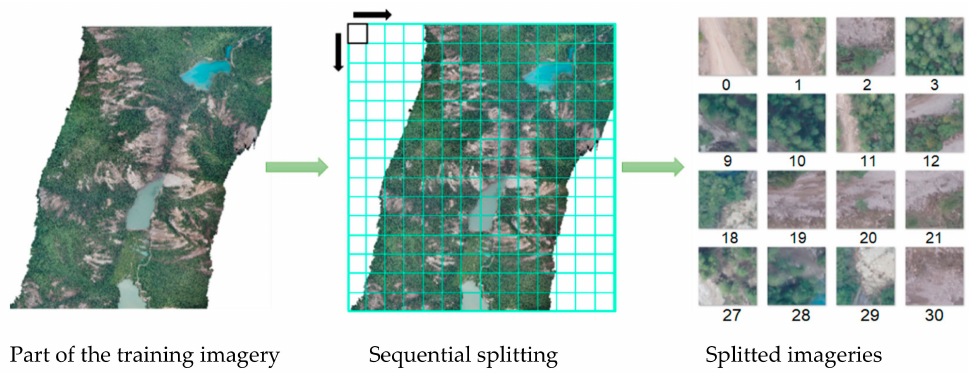
Figure 10. Data set production.